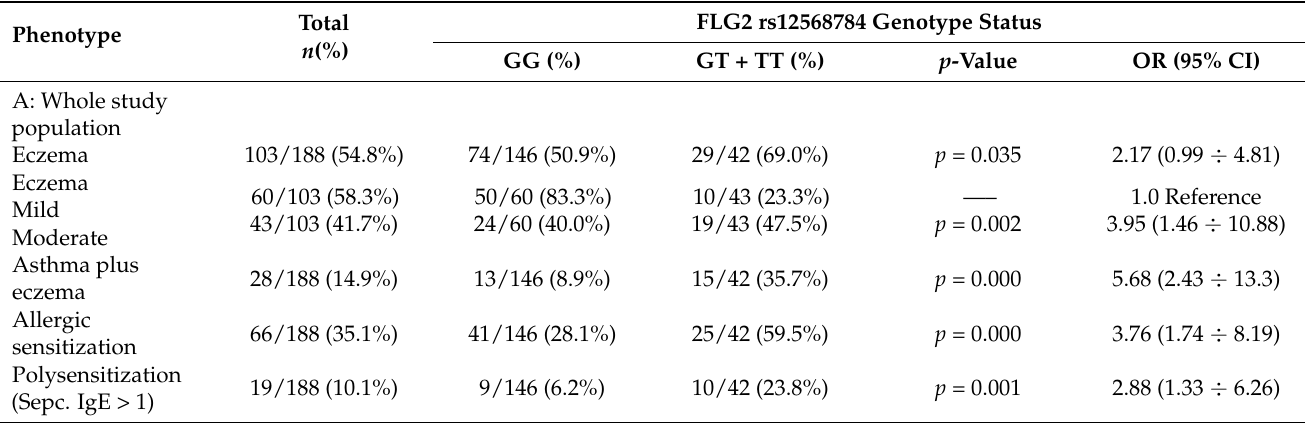
Table 3. Associations between the FLG2 rs12568784 genotype and allergic